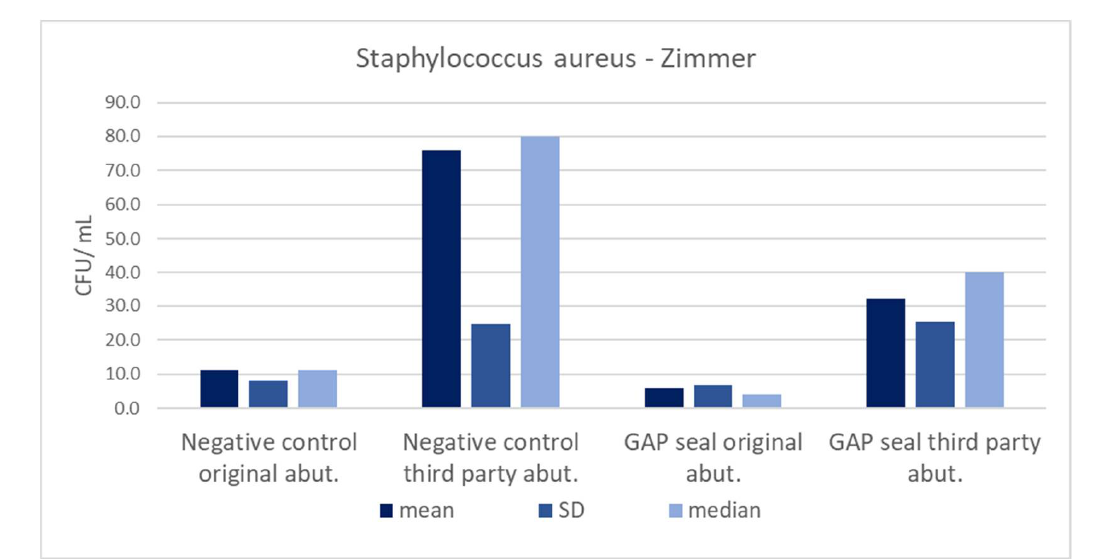
Figure 10. Mean counts of Staphylococcus aureus detected on the internal surface of Zimmer implants depending on the abutment fabrication method (original and third-party) and the need for the use of the gap sealing material.